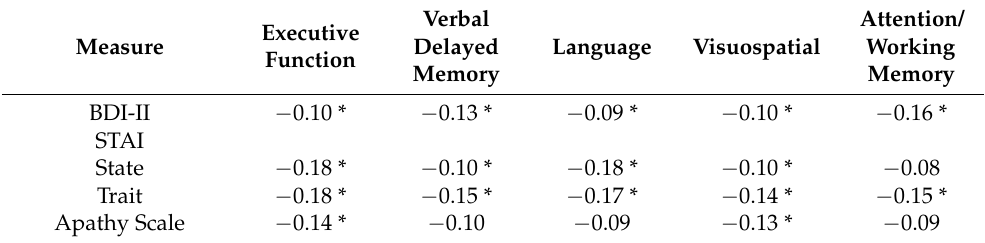
Table A2. Pearson correlations between mood measures and composite z -scores.